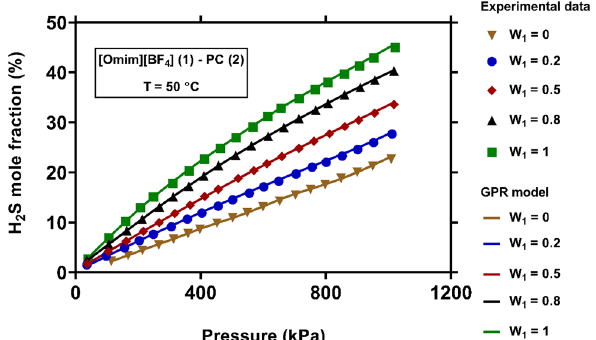
Figure 9. Comparison between experimental values of H 2 S solubility and those predicted by the novel model at various mass fractions of solvent components (created by GraphPad 8.4.3.686 145 ).